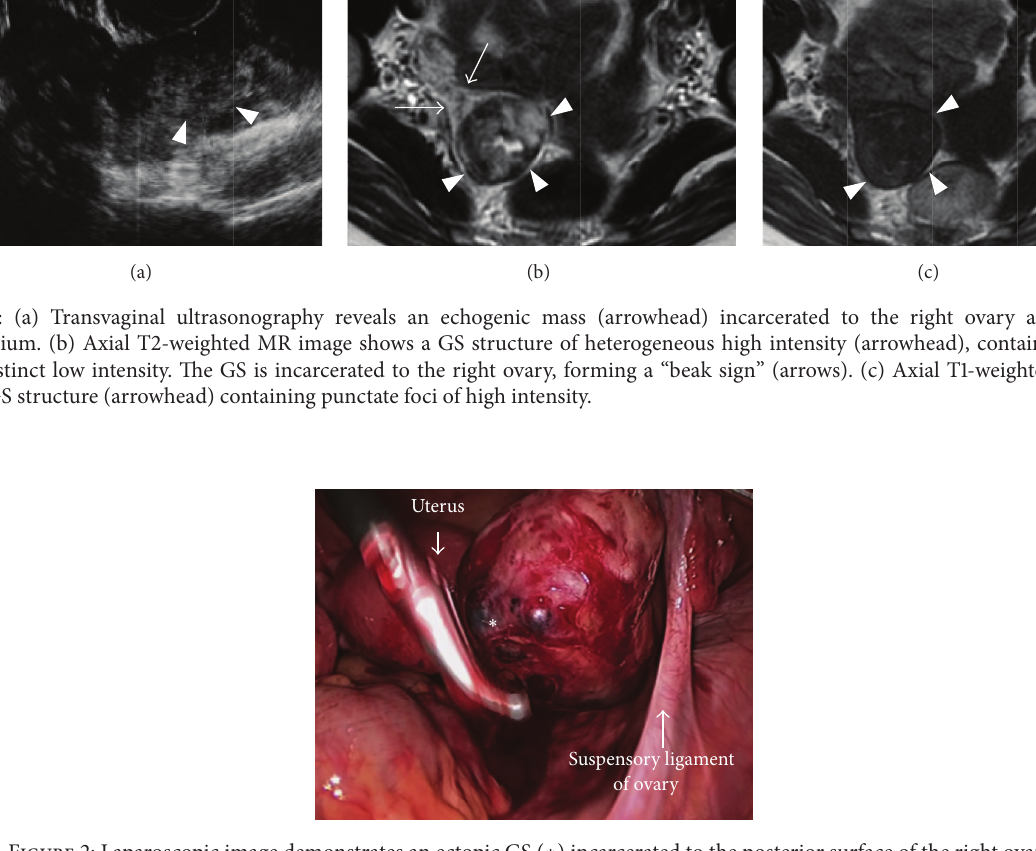
tured right ovarian pregnancy, with a GS structure attached to the posterior surface of the ovary (Figure 2). Unilateral